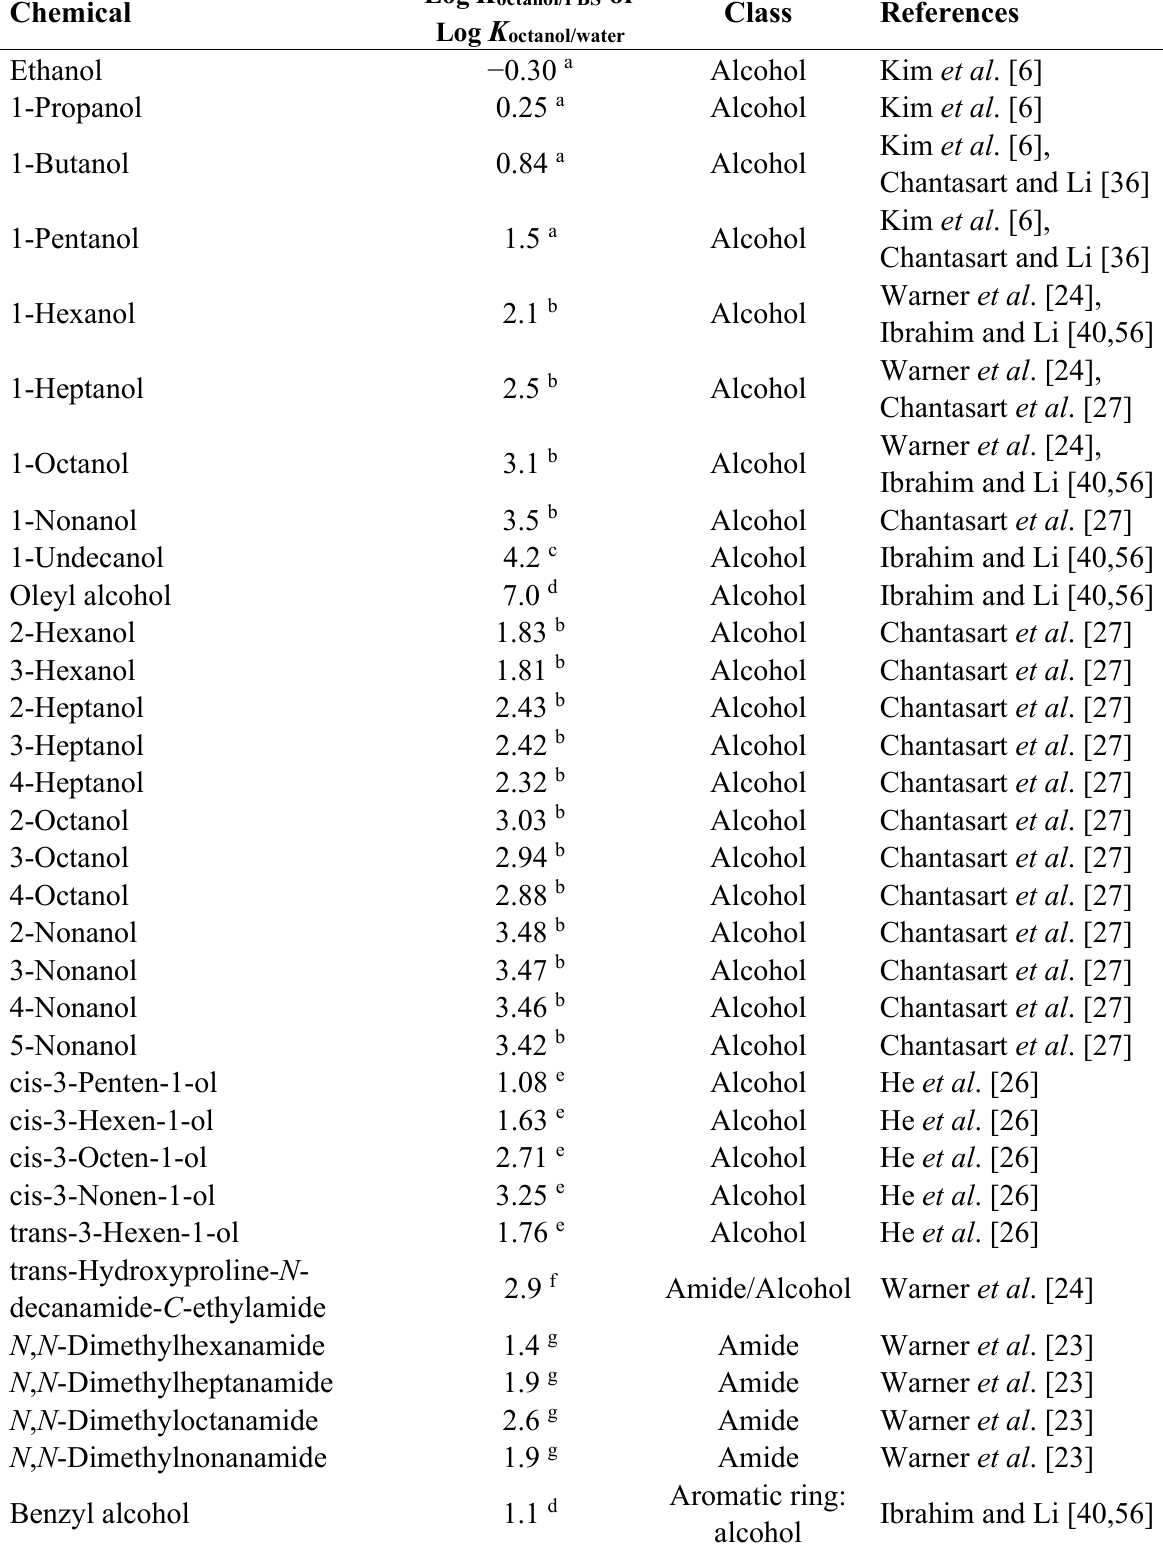
Table 1. Skin penetration enhancers studied (listed alphabetically according to chemical